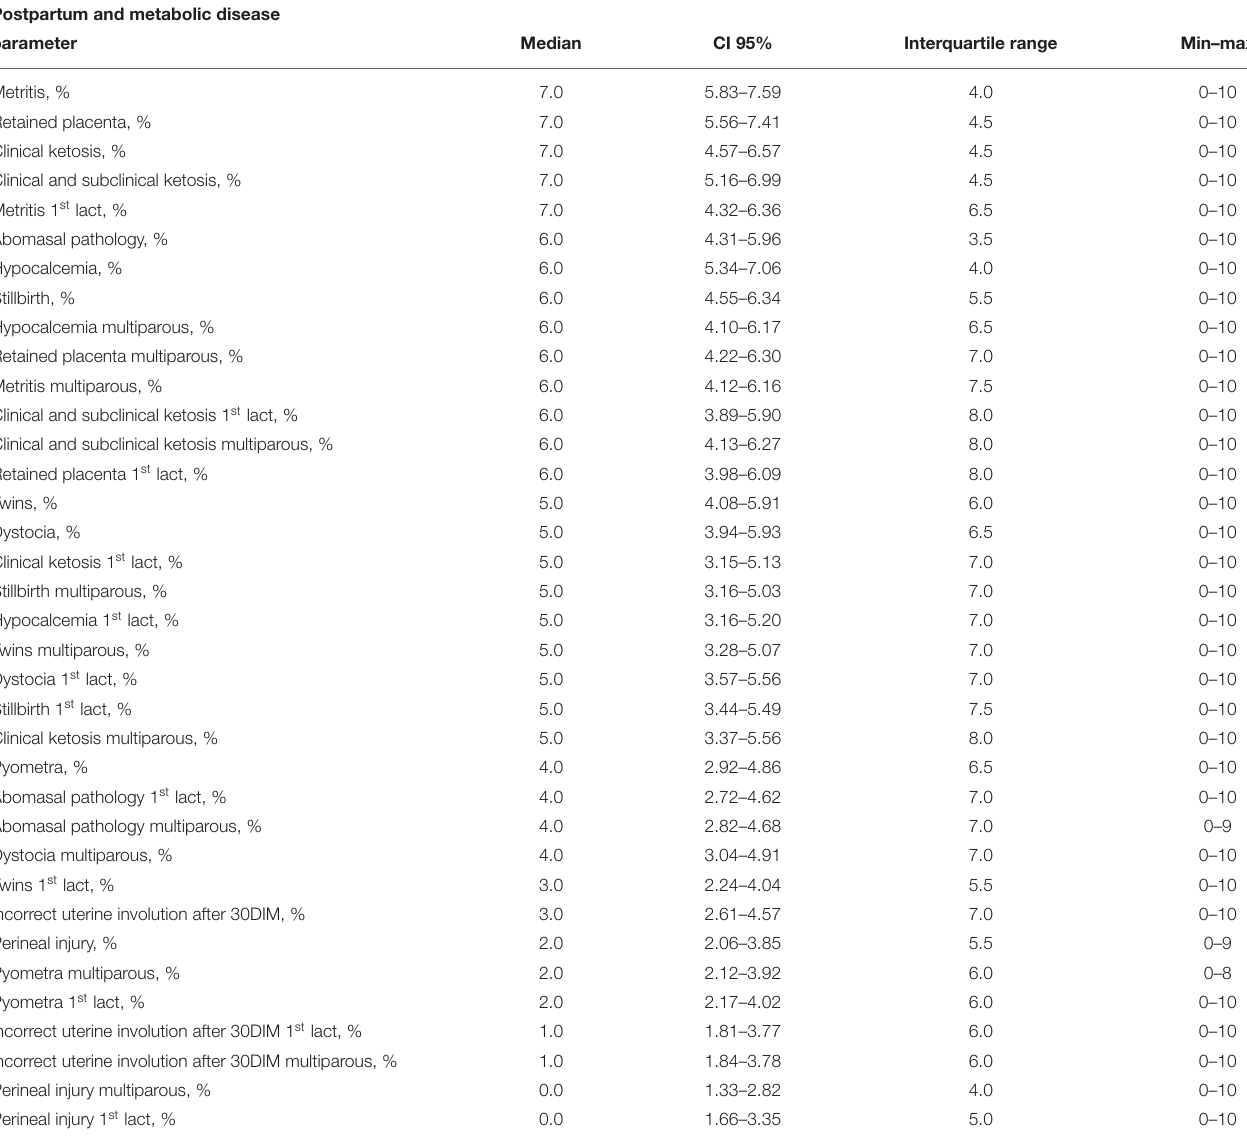
TABLE 5 | Answers given by consultants on Section 4: Postpartum and Metabolic Diseases, where 0 is of minimal or irrelevant importance and 10 represents the maximum importance. Postpartum and metabolic